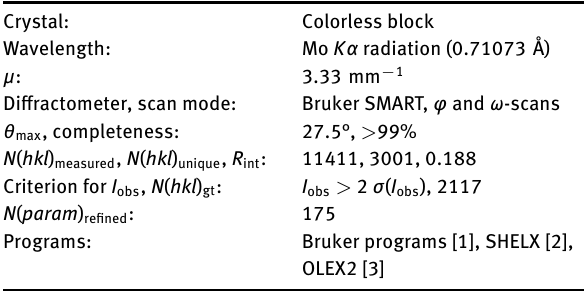
Table 2: Fractional atomic coordinates and isotropic or